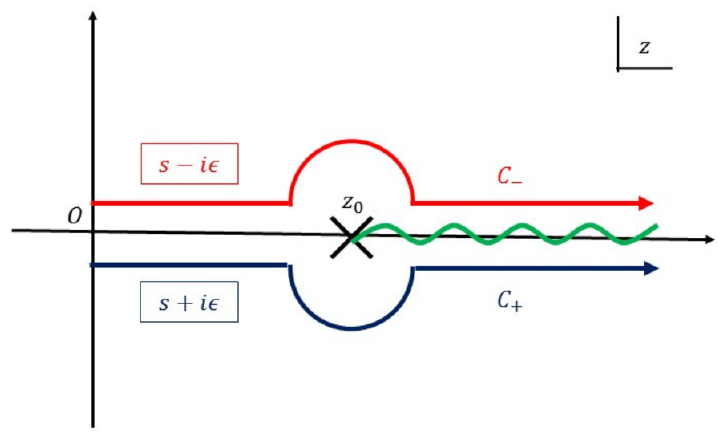
Figure 2 . Integration contours C + and C (cid:0) on the Borel